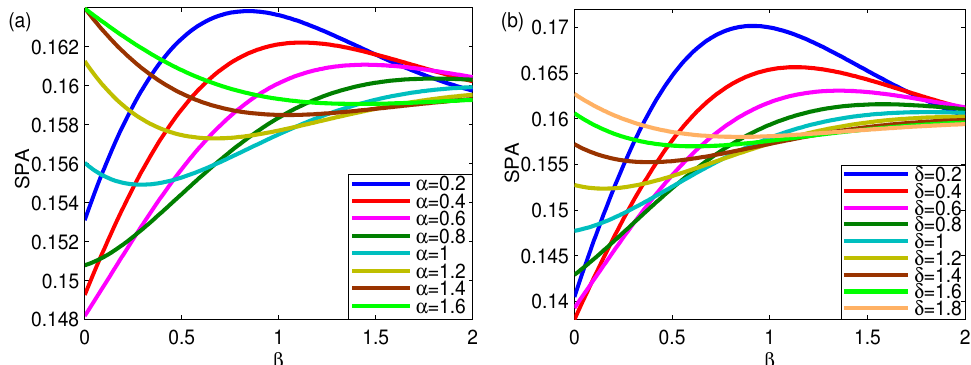
Figure 6. GSR behaviors of SPA( β ) in (35) for different ( a ) α and ( b ) δ . ( a ) ¯ γ = 0.1, δ = 1.65, τ = 0.1, a 2 = 0.2, q = 0.3, λ = 0.6, ω 0 = 1, Ω = 2, µ = ν = 0.8; ( b ) ¯ γ = 0.1, α = 1.2, τ = 0.1, a 2 = 0.2, q = 0.3, λ = 0.6, ω 0 = 1, Ω = 2, µ = ν = 0.8.